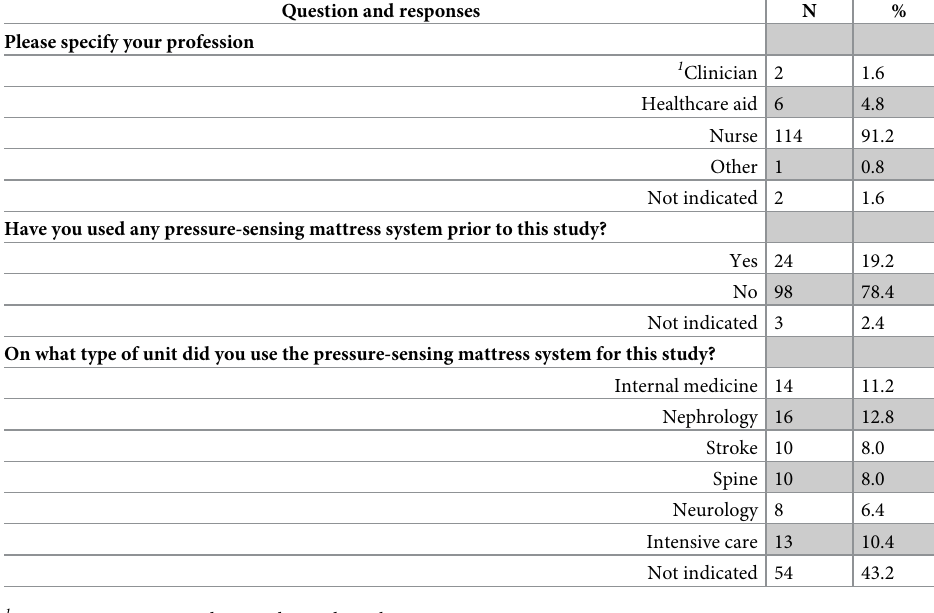
Table 1. Characteristics of healthcare providers who completed the